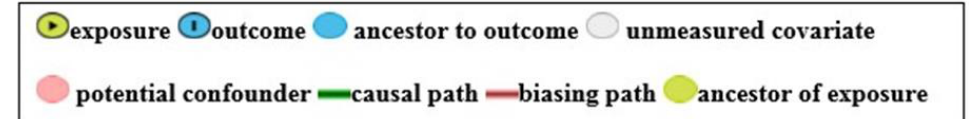
Figure 1. A Directed Acyclic Graph (DAG) for the association between Carers’ Smoking Status and Childhood Obesity.